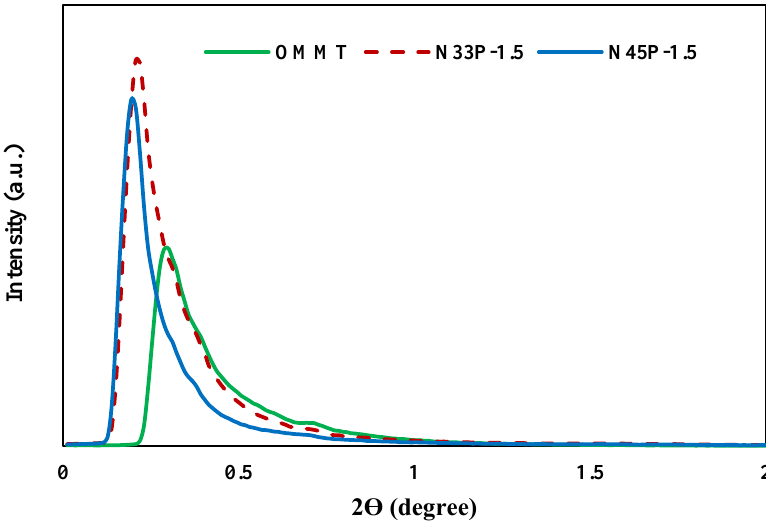
Figure 2. X-ray diffraction patterns of OMMT, N33P-1.5, and N45P-1.5.